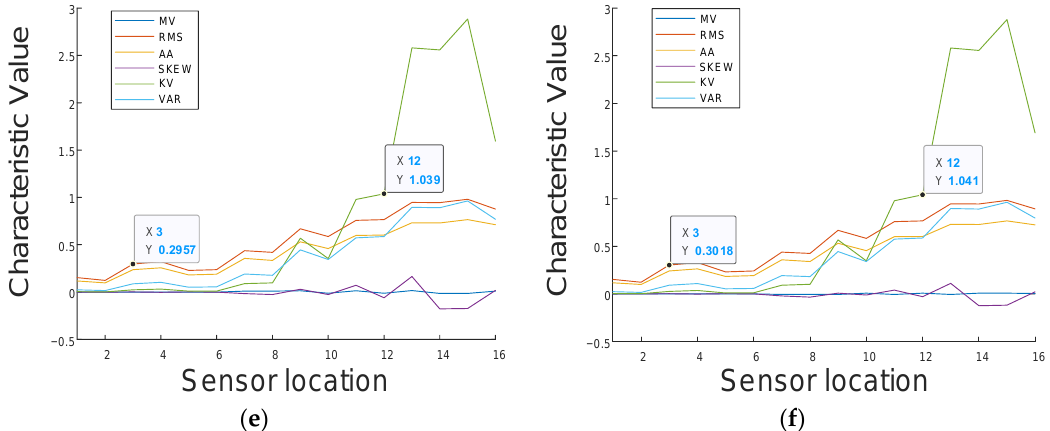
Figure 11. Data characteristics of motion data: ( a ) data characteristics of the first half of the first joint, ( b ) data characteristics of the second half of the first joint, ( c ) data characteristics of the first half of the second joint, ( d ) data characteristics of the second half of the second joint, ( e ) data characteristics of the first half of the third joint, and ( f ) data characteristics of the second half of the third joint. The signal features of the three joints in motion are input into the probability model program. The optimal layout evaluation is calculated circularly, and the corresponding redundancy is calculated. The optimal layout order is [1.56, 1.37, 1.18, 0.8, 0.8, 1.47, 0.7, 1.18, 0.8, 1.37, 0.2, 1.47, 0.7, 0.5, 0.5, 0.2]. By observing the distribution of objective function values, as shown in Figure 12, and considering the problem of the degree of freedom of the industrial robot, ten sensors are selected to be arranged. The optimal sensor layout is [1.56, 1.37, 1.18, 0.8, 0.8, 1.47, 0.7, 1.18, 0.8, 1.37]. The corresponding objective function value is 2.716. The empirical layout and uniform layout are shown in Figure 13.